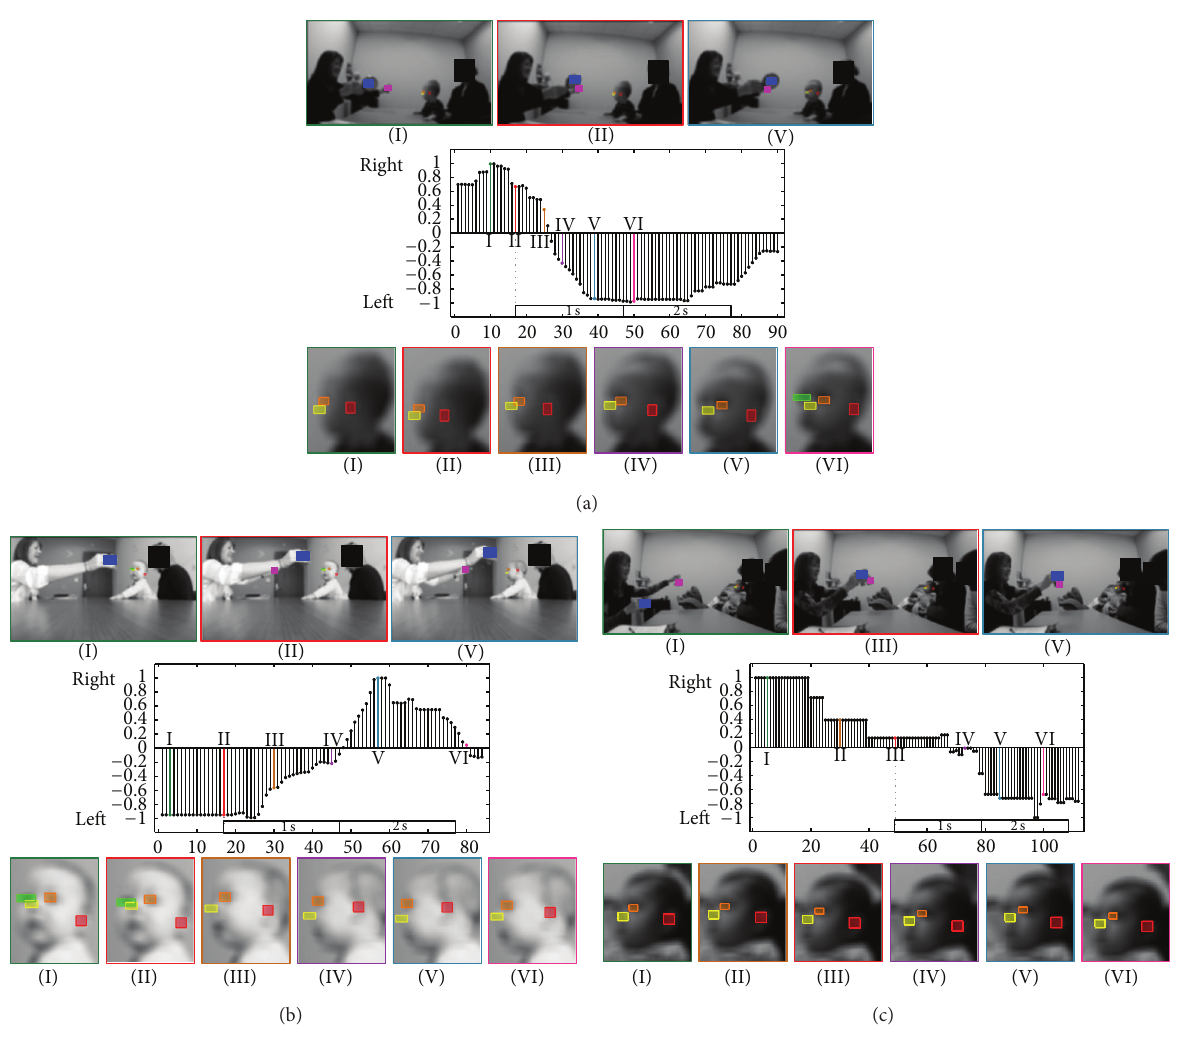
Figure 2: (a) First example of the Disengagement of Attention task. Top: when the clinician is holding one object, when the second object appears, and when the child recognizes the second object. Middle: changes in the yaw motion ( ̂ yaw values in the 𝑦 -axis; see Appendices A and B) for every frame ( 𝑥 -axis). The dotted line represents when the second object is presented, followed by boxes representing 1 and 2 seconds after the object is presented. Bottom: 6 examples of the infant’s face during the task. All facial features are automatically detected and tracked (as indicated by the colored boxes around the nose, eyes, and ear). Colors and roman numerals identify corresponding images and spikes in the graph. (b, c) Two examples of the Disengagement of Attention